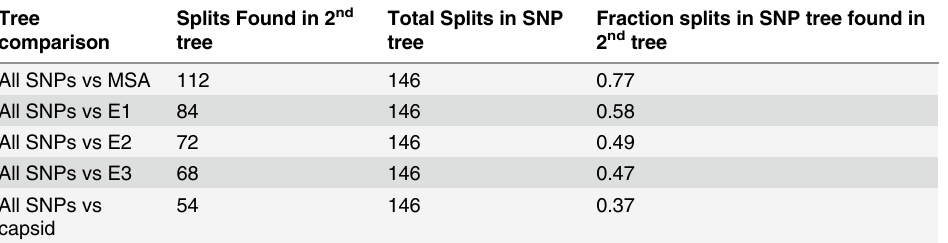
Table 4. Comparison of trees from multiple sequence alignment versus all SNPs, and trees from SNPs located in a single gene versus all SNPs. Tree Splits Found in 2 comparison